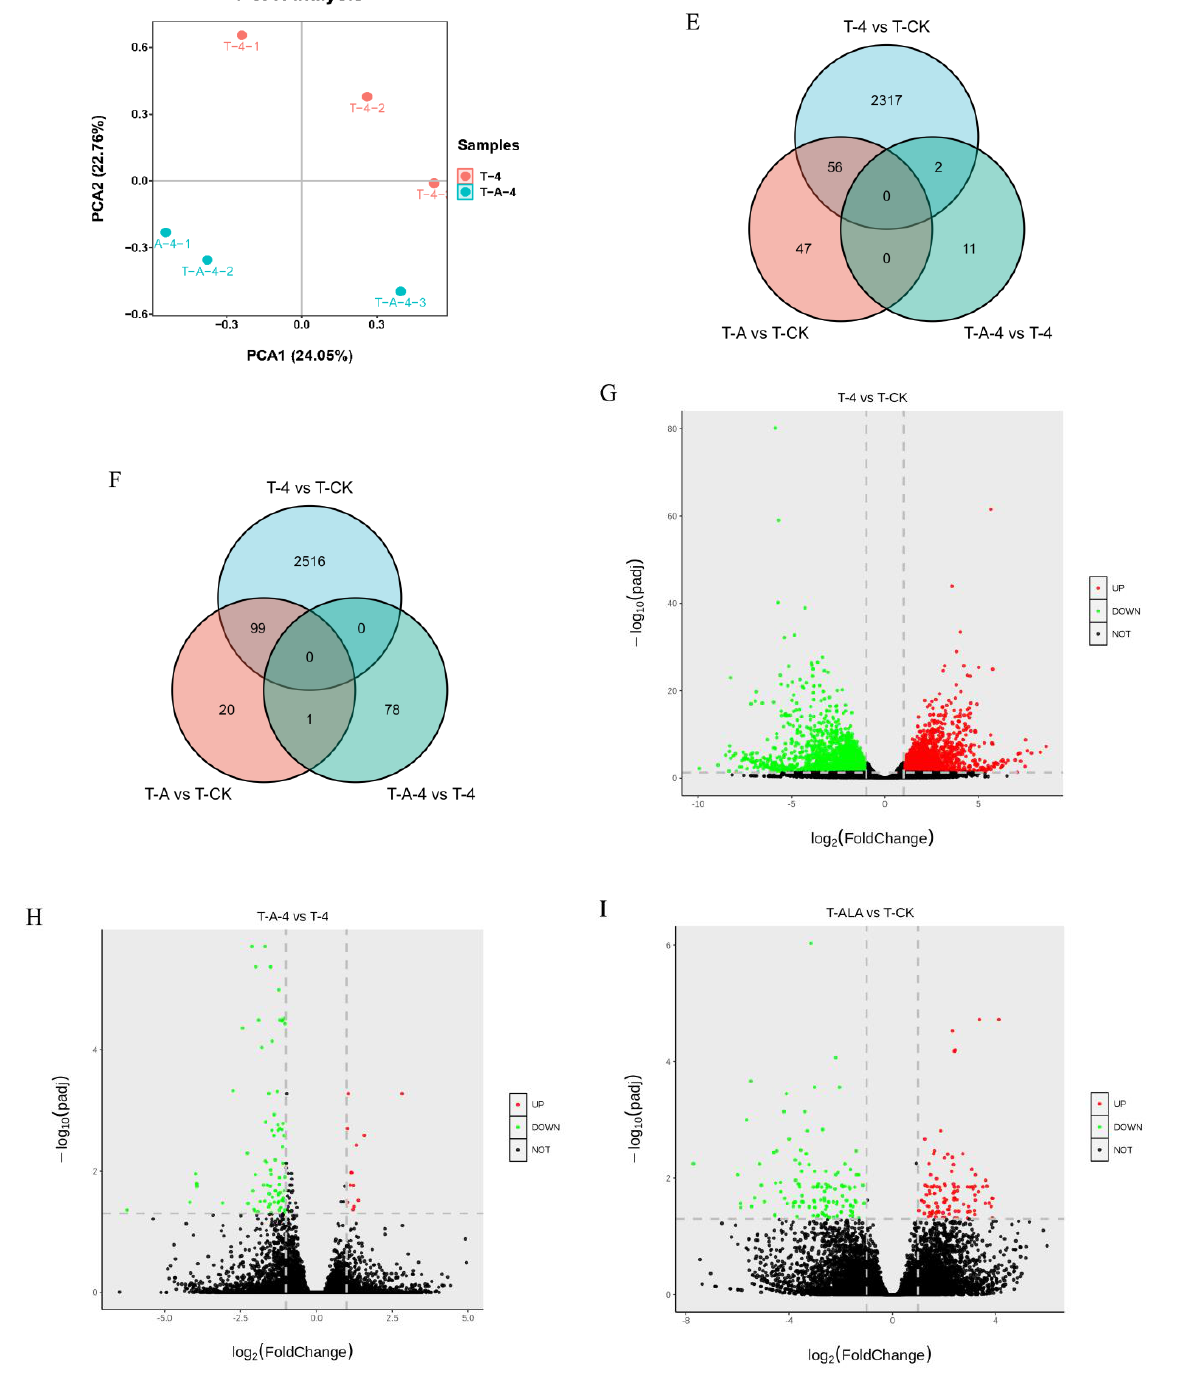
Figure 1. Landscape of the transcriptomic patterns of tea leaves after T-4, T-A and T-A-4 treatments. ( A ): Correlation analysis on all samples depicting two distinct clades: samples of T-CK with T-A and T-4 with T-A-4. ( B – D ) Principle component analysis (PCA) on the transcriptomic profiles of tea leaves after T-4, T-A, T-A-4 treatments compared with untreated control. Four regions within 95% confidence intervals were formed in the PCA plots. ( E , F ) Venn diagram of up-regulated and down-regulated genes in T-A vs. T-CK, T-4 vs. T-CK and T-A-4 vs. T-4 pairwise comparisons. ( G – I ) Volcano plots illustrated the differentially expression genes in T-4 vs. T-CK, T-A-4 vs. T-4 and T-ALA vs. T-CK pairwise comparisons. The up-regulated and down-regulated genes were exhibited in red and green, respectively, whereas black dots showed no significant genes in each